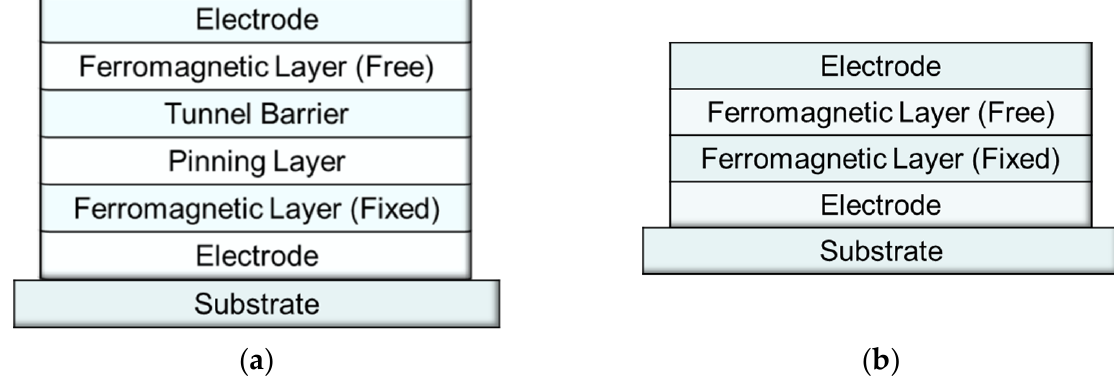
Figure 1. The schematic diagrams of different MTJs: ( a ) A common MTJ; and ( b ) A spin-filter MTJ. Two-dimensional CrI 3 multilayers were recently adopted to design and fabricate sf- MTJs in laboratory [28]. The two-dimensional CrI 3 multilayer has an A-type magnetic order [29], which means that its intralayer coupling is FM while its interlayer coupling is antiferromagnetic (AFM) [30]. Figure 2a presents an A-type AFM bilayer with an intralayer FM order but interlayer AFM coupling, where the two layers have opposite magnetic moments. A large enough external in-plane (out-of-plane) magnetic field can switch the in- terlayer coupling from an interlayer AFM to FM order [28], meaning that the magnetization changes from antiparallel to parallel, as shown in Figure 2b (the magnetization in a large in-plane magnetic field) and Figure 2c (the magnetization in a large out-of-plane magnetic field). As a result, we can employ the A-type AFM multilayer instead of FM layers with different coercivities to design sf-MTJ. Of course, the A-type layers must be insulators or semiconductors because they also work as tunnel barriers.